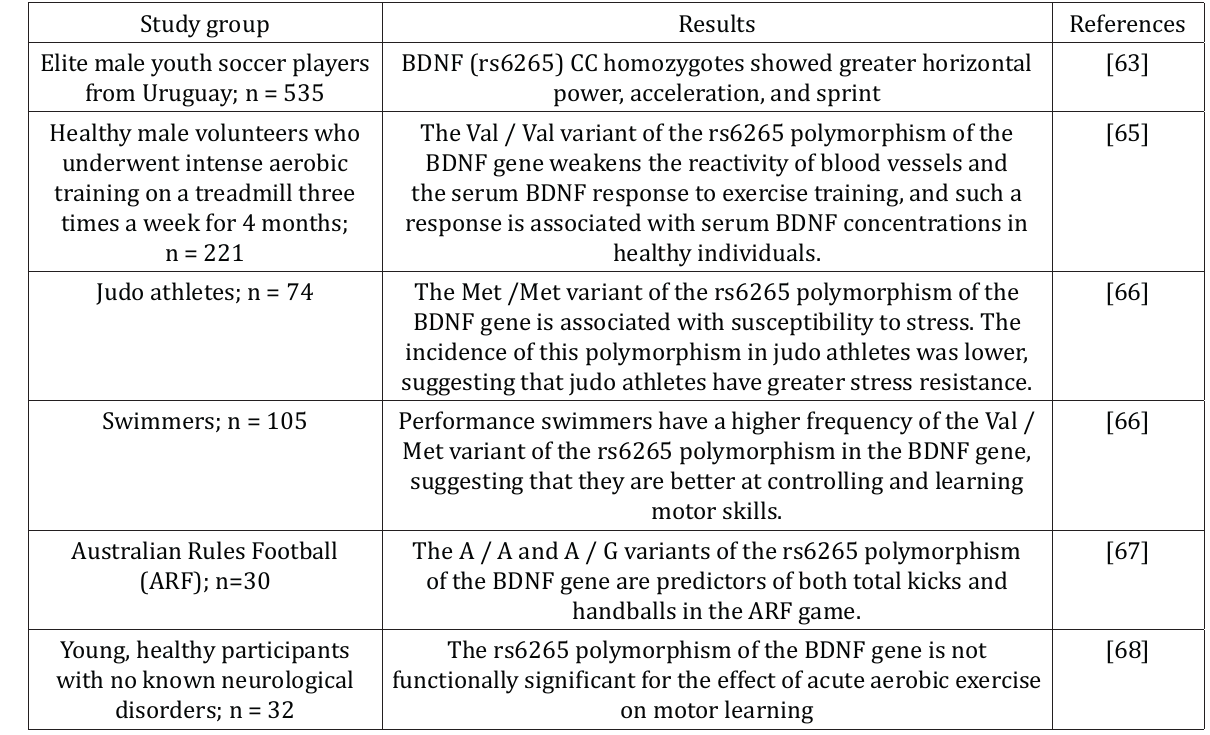
Table 3. Relationship of the rs6265 polymorphism of the BDNF gene and achievements in sport